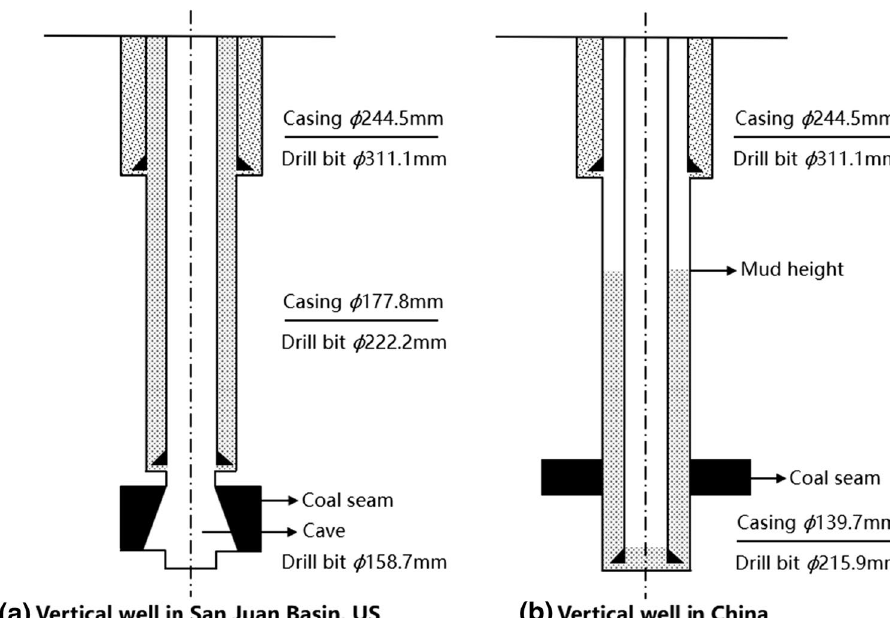
Fig. 2 Schematic of the well- bore structure of CBM vertical wells, modified from Shen et al.